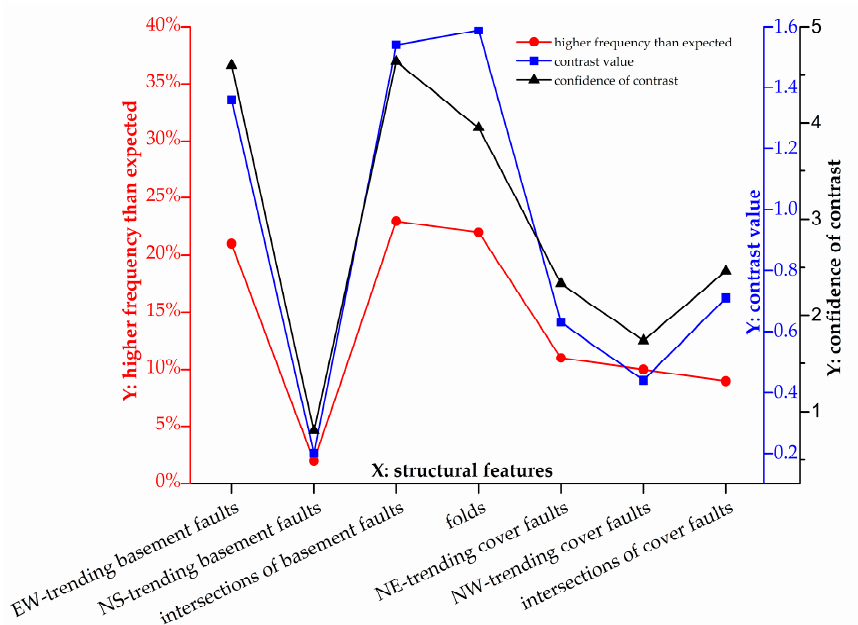
Figure 12. ( a ) Buffer analysis and ( b ) graph of cumulative relative frequency concerning distance to intersections of cover faults.